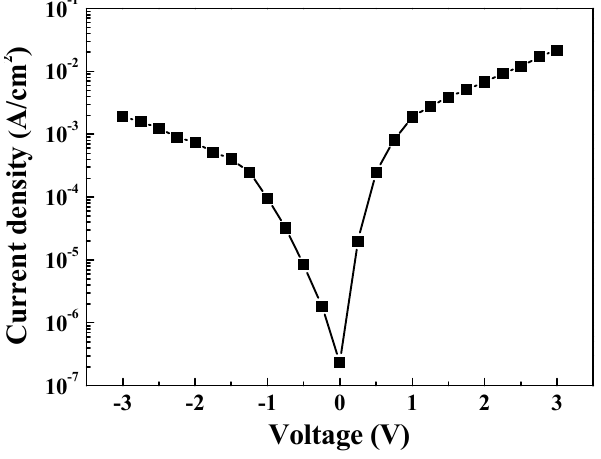
Figure 11. Log current–voltage curve of the L2NiO / ITO transparent heterojunction